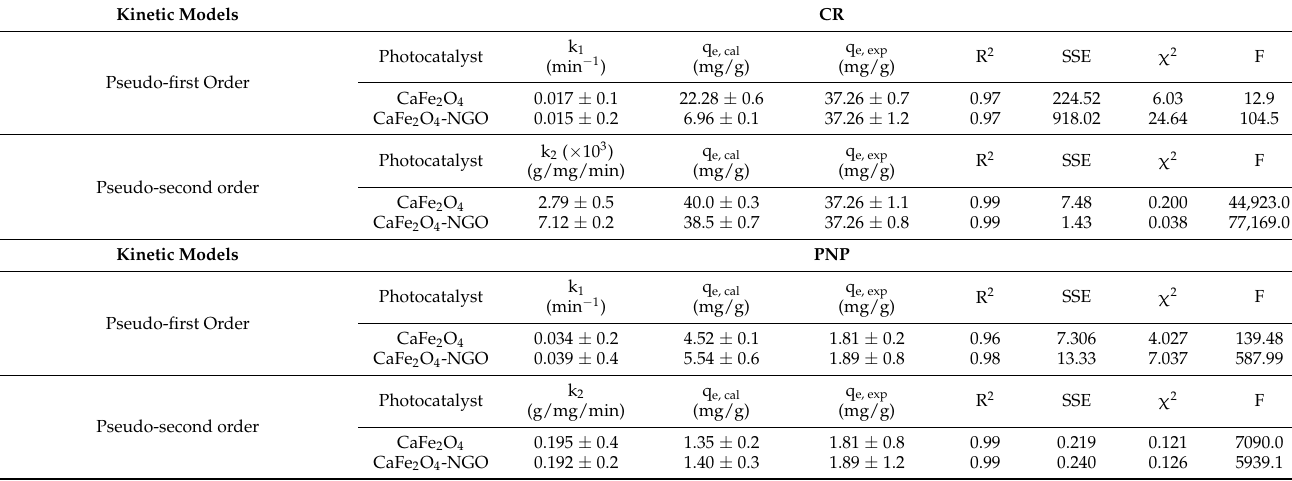
Figure 10. ( a , b ) Effect of contact time on CR and PNP adsorption. ( c , d ) pseudo-second order for CR and PNP adsorption. Table 6. Rate constant, equilibrium adsorption capacity, regression coefficient and statistical data of pseudo-first and second-order kinetic models of CR and PNP onto CaFe 2 O 4 and CaFe 2 O 4